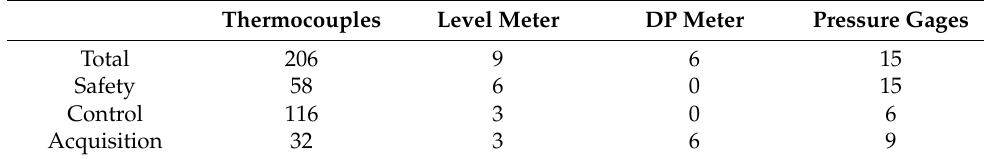
Table 2. Recap of sensors mounted on the